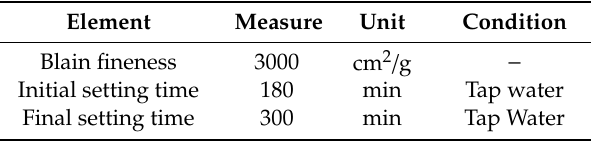
Table 2. Physical and mechanical properties of used